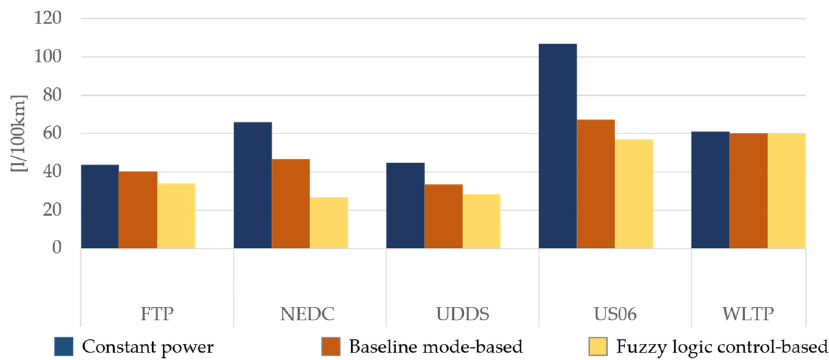
Figure 15. Comparison of equivalent consumption per 100 km [L/100 km].